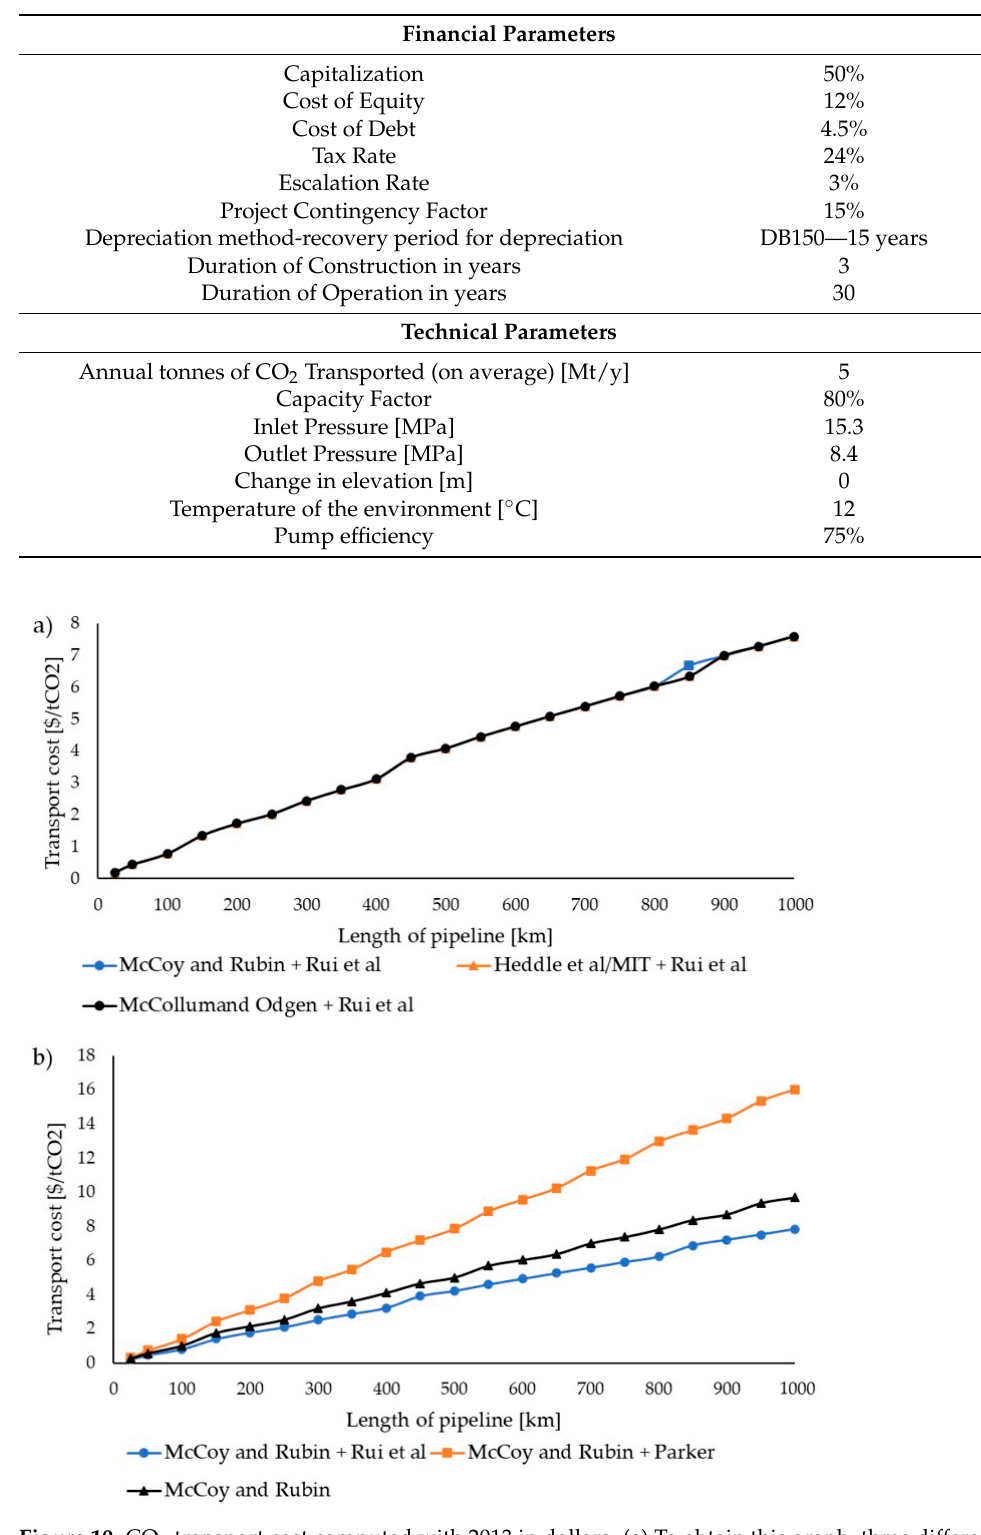
Figure 10. CO 2 transport cost computed with 2013 in dollars. ( a ) To obtain this graph, three differ- ent methods are used to calculate the inner diameter while the same method (Rui et al.) is used